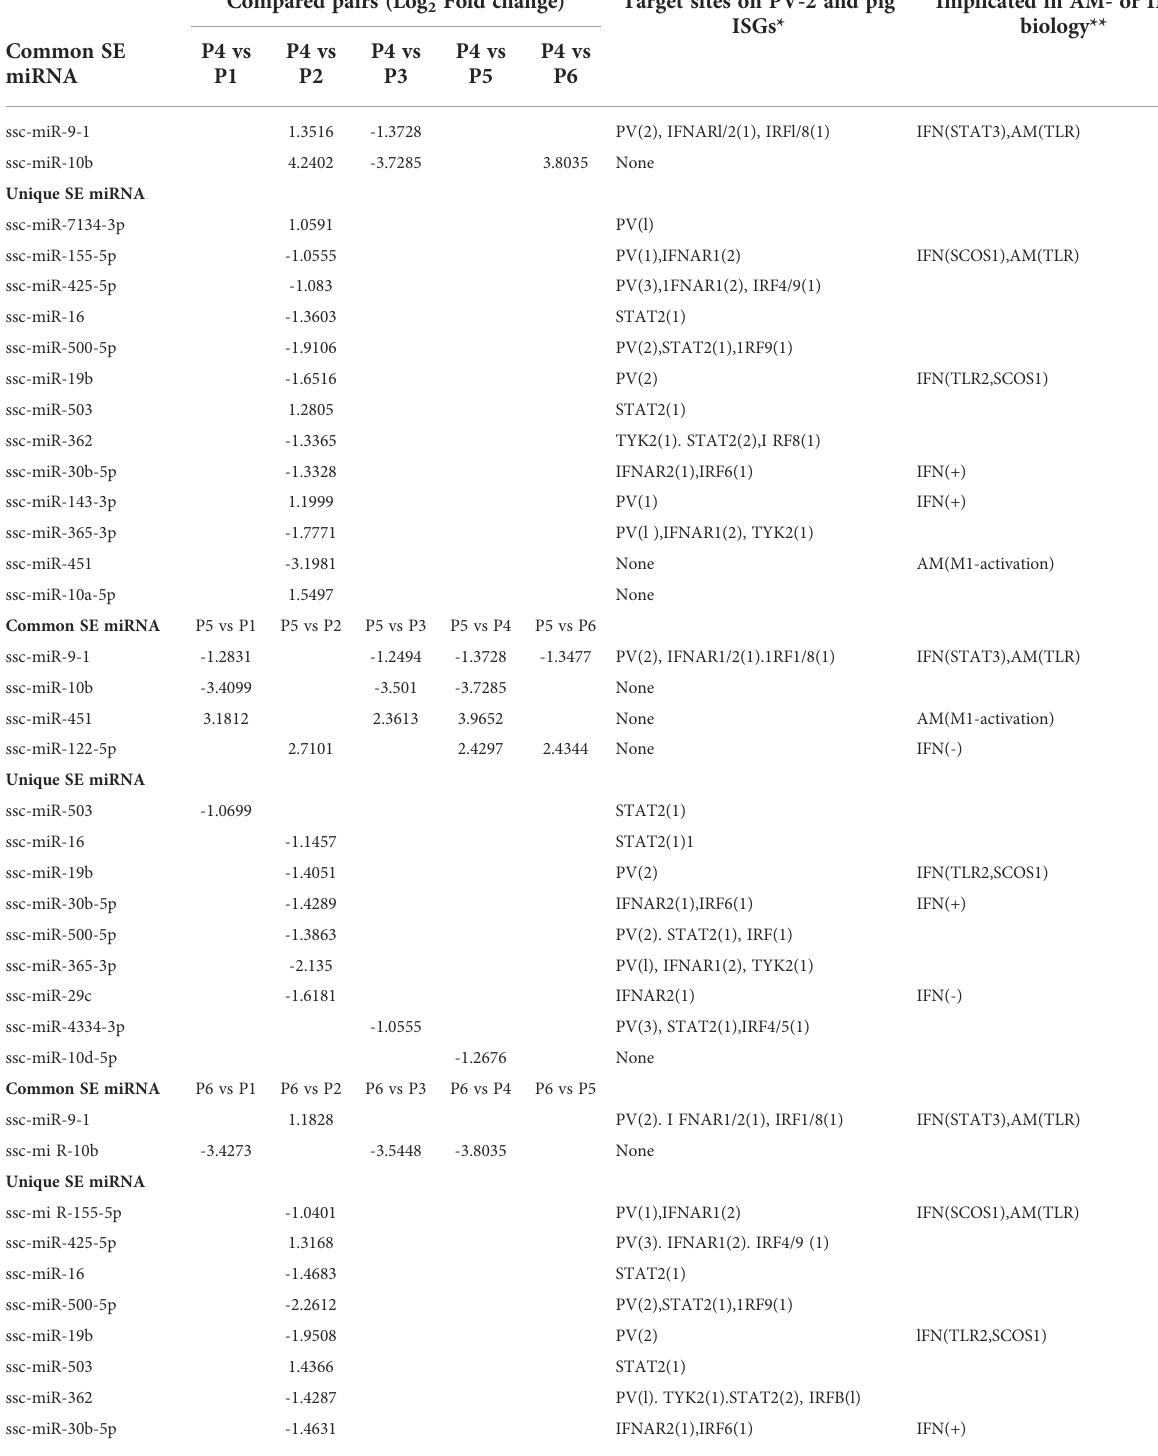
TABLE 6 Top ranked SEM shared or unique in compared